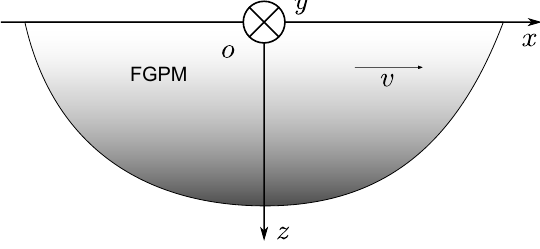
Figure 1. The functionally graded piezoelectric material half-space and coordinate